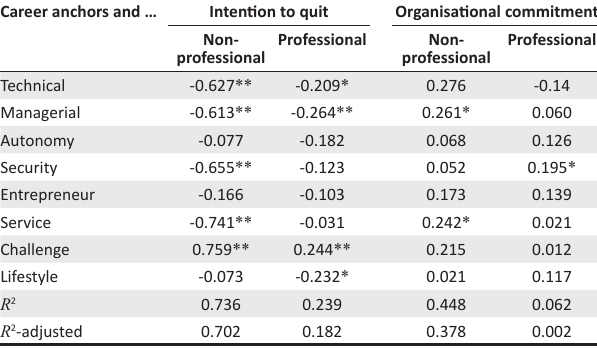
TABLE 2: Correlation between career anchors and intention to quit and organisational commitment per staff status. Career anchors and …